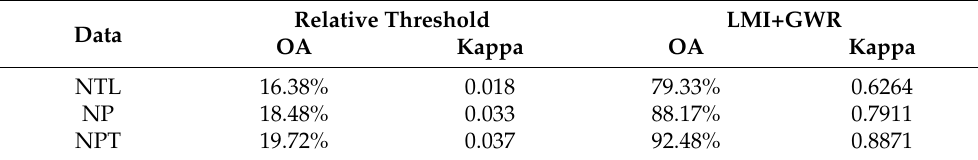
Table 3. Confusion